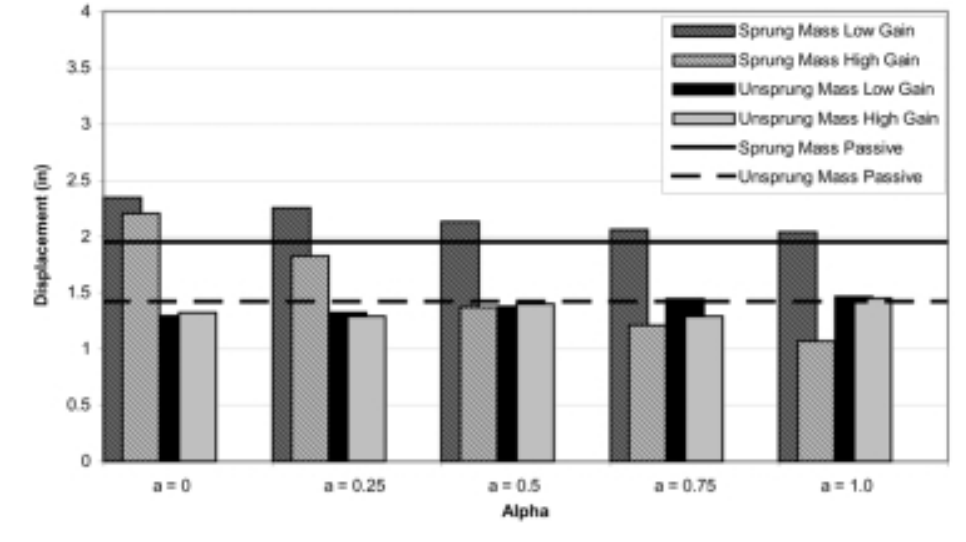
Fig. 10. Transient Peak-to-Peak Displacement.